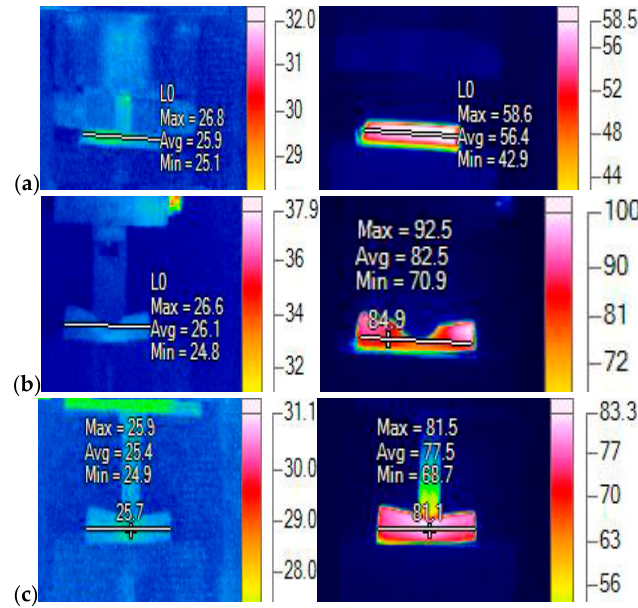
Figure 7. Thermal responses under various loadings (unit: degC) at SOC = 0.2: ( a ) two rigid plates, ( b ) a rigid rod, and ( c ) a hemispherical punch.